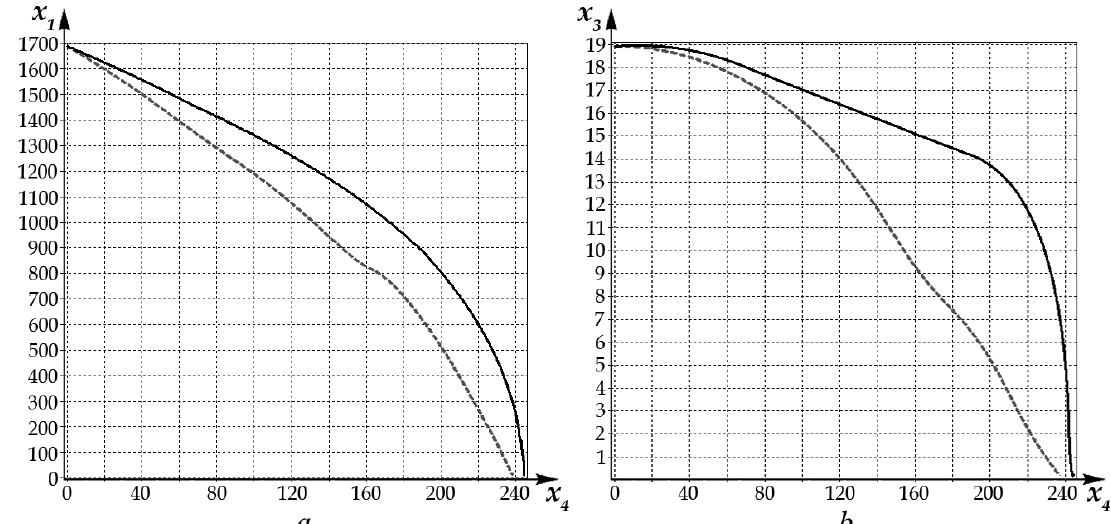
Figure 4. The graphs of trajectories: ( a ) spacecraft speed over distance x 1 ( x 4 ) ; ( b ) spacecraft altitude over distance x 3 ( x 4 ) . Found solution—black solid line; reference solution—grey dashed